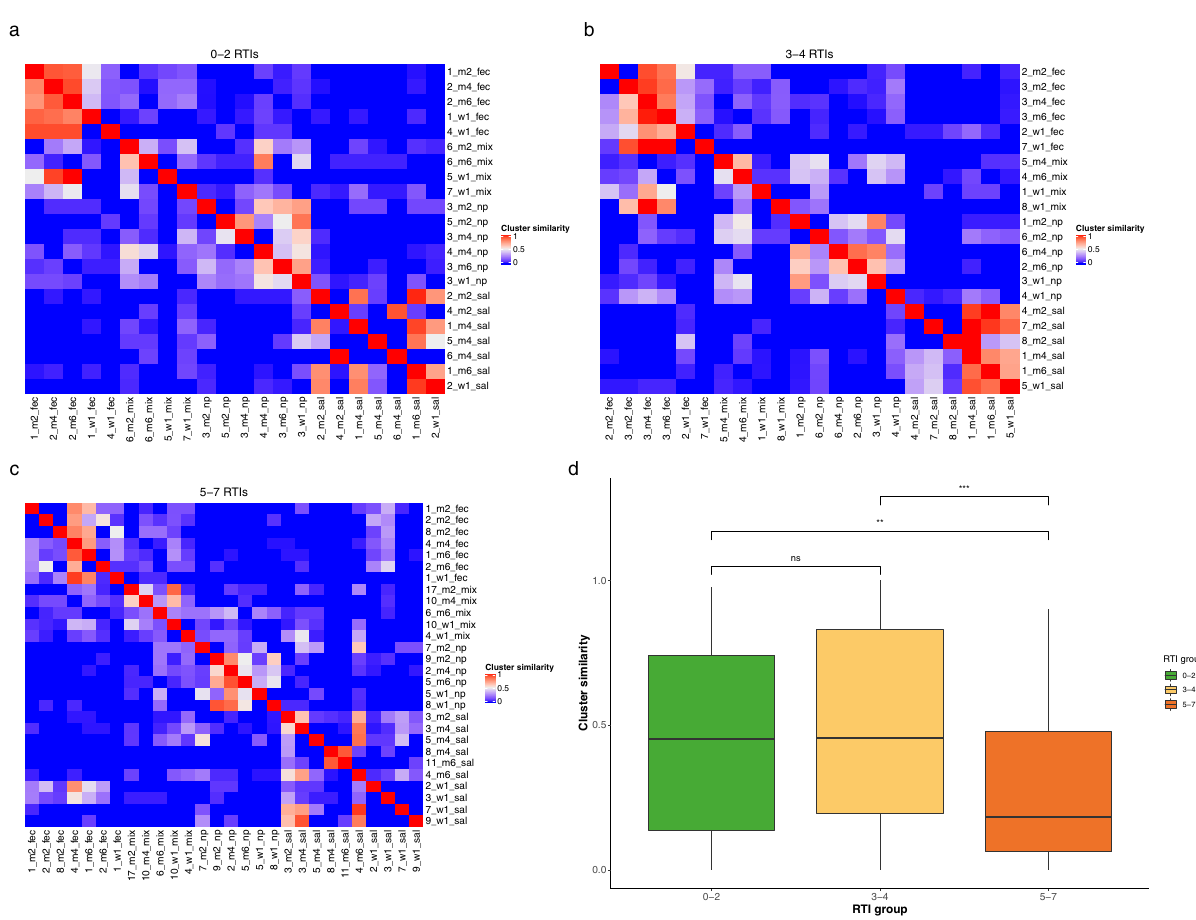
Fig. 4 Stability and similarity of individual network clusters. Heatmaps ( a – c ) displaying the similarity between the cluster compositions of all clusters at all time points for networks for the 0 – 2 RTI group, 3 – 4 RTI group and 5 – 7 RTI group, respectively. Cluster similarity was calculated as the proportion of OTUs shared between two clusters (1 represents complete overlap between all OTUs of two clusters, whereas 0 represents no OTUs being shared between two clusters). Each cluster is labelled with a unique number to distinguish between clusters with the same niche-identity, the time point of the network from which the cluster originates (w1 = week 1, m2 = month 2, m4 = month 4, m6 = month 6) and the niche-identity of the cluster (fec = faecal cluster, np = nasopharyngeal cluster, sal = saliva cluster, mix = no clear niche-identity of cluster). d Mean cluster similarity for all clusters per RTI group across time. The number of clusters that are compared to each other is n = 22 for 0 – 2 RTIs, n = 22 for 3 – 4 RTIs, and n = 28 for 5 – 7 RTIs. Boxplots with medians are shown; the lower and upper hinges correspond to the fi rst and third quartiles (the 25th and 75th percentiles); the upper and lower whiskers extend from the hinge to the largest and smallest value no further than 1.5 *IQR from the hinge. In order to assess the extent by which microbial communities from multiple body sites are linked and related to disease susceptibility, Reyman and Clerc et al. combined 16S-based rRNA sequencing data from 112 healthy, term born infants, spanning three body sites (oral cavity, nasopharynx, and gut) over the fi rst 6 months of life. They demonstrate a strong association between network structure and species and susceptibility to respiratory tract infections, suggesting a crucial role of cross-niche microbial connections in respiratory